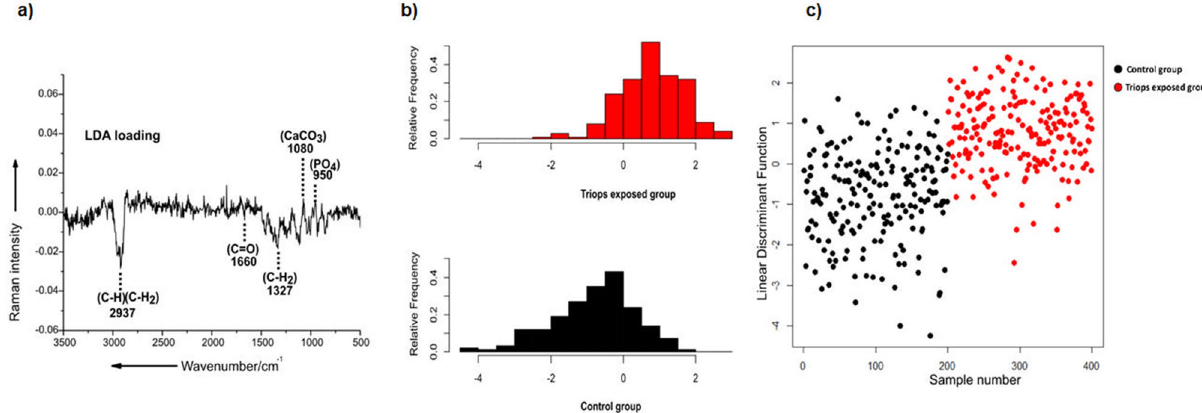
Figure 5. PCA-LDA analysis of the Raman spectra acquired from the carapace samples of control and Triops -exposed D. magna ; (a) loading of the PCA-LDA model for the differentiation of carapace samples of control and Triops- exposed D. magna ; (b) PCA-LDA histogram plot, the horizontal axis describes the linear discriminant function values and the vertical axis the relative frequencies of each class. The histogram coded in black represents the control group and that coded in red represents the Triops -exposed group. The data analyzed was obtained from 8 replicates (carapace samples) per group constituting 25 spectra per replicate, meaning 200 spectra per treatment and a total of 400 spectra acquired across the two groups; (c) PCA-LDA score plot showing the variation between the two groups of samples, the black dots represent all the spectra of the control group (n = 200) and the red dots represent all the spectra of the Triops -exposed group (n =